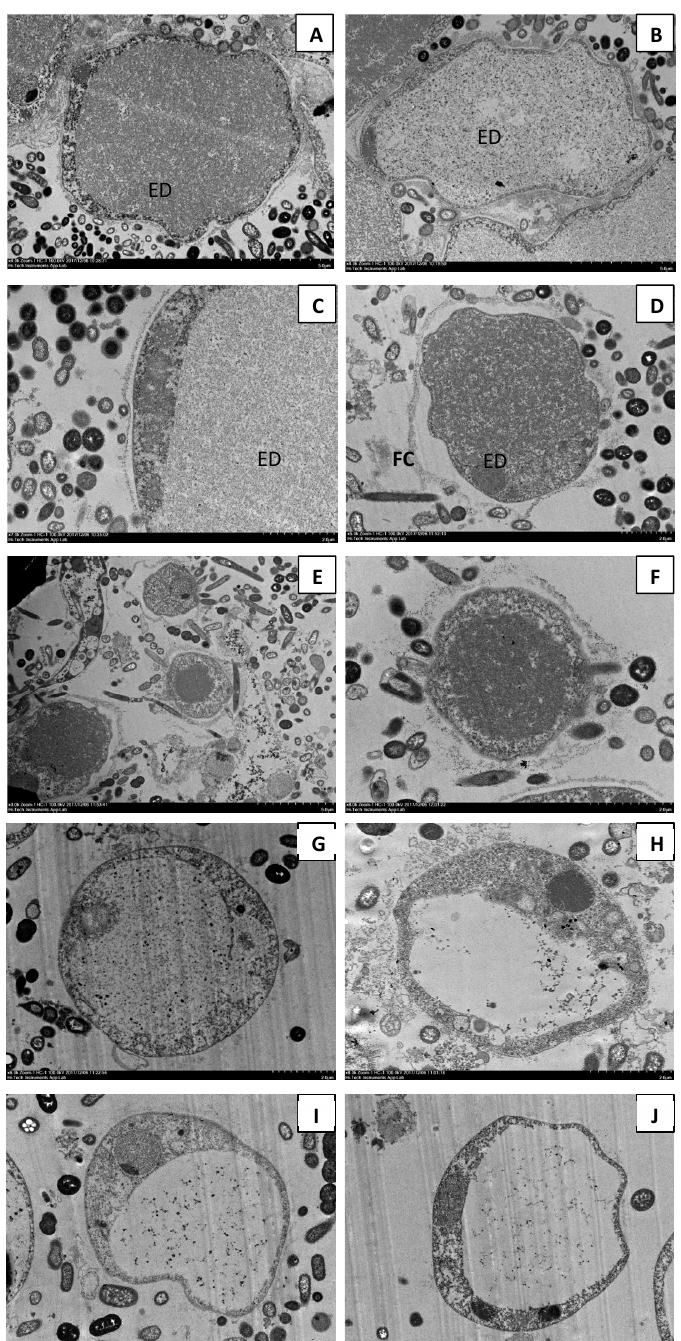
Figure 4. Transmission electron microscopy (TEM) comparison between Blastocystis sp. isolated from urban and orang asli individuals. ( A – C ) Isolates obtained from symptomatic urban individu- als with an intact fuzzy coat (FC). ( D – F ) Parasite isolated from asymptomatic urban individuals showing detached FC. ( G , H ) Isolates obtained from symptomatic orang asli individuals with rounded cells and prominent central vacuole. ( I , J ) Isolates obtained from asymptomatic orang asli individuals with a prominent central vacuole. Note: (ED) Electron-dense material.